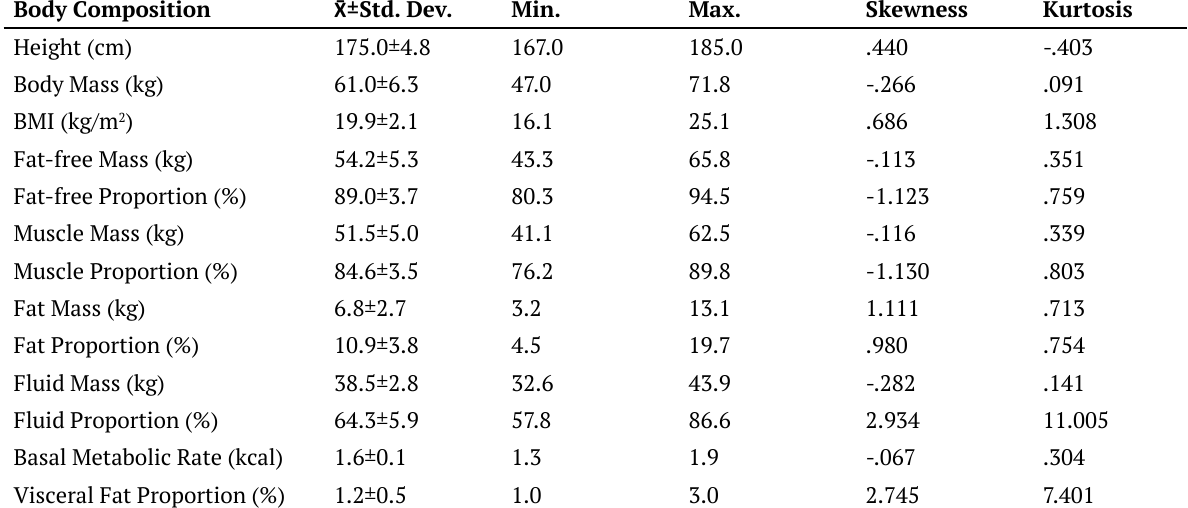
Table 1. Descriptive Statistics Results for Body Composition (n=20)